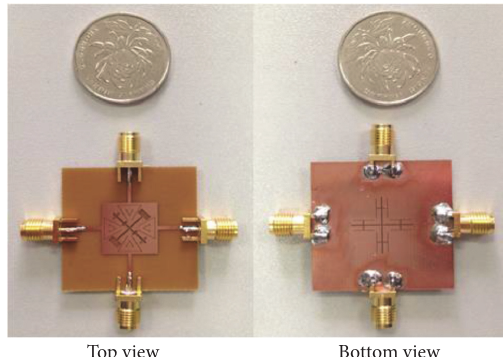
three sets of data; the measured S11 is about − 11 dB and − 10